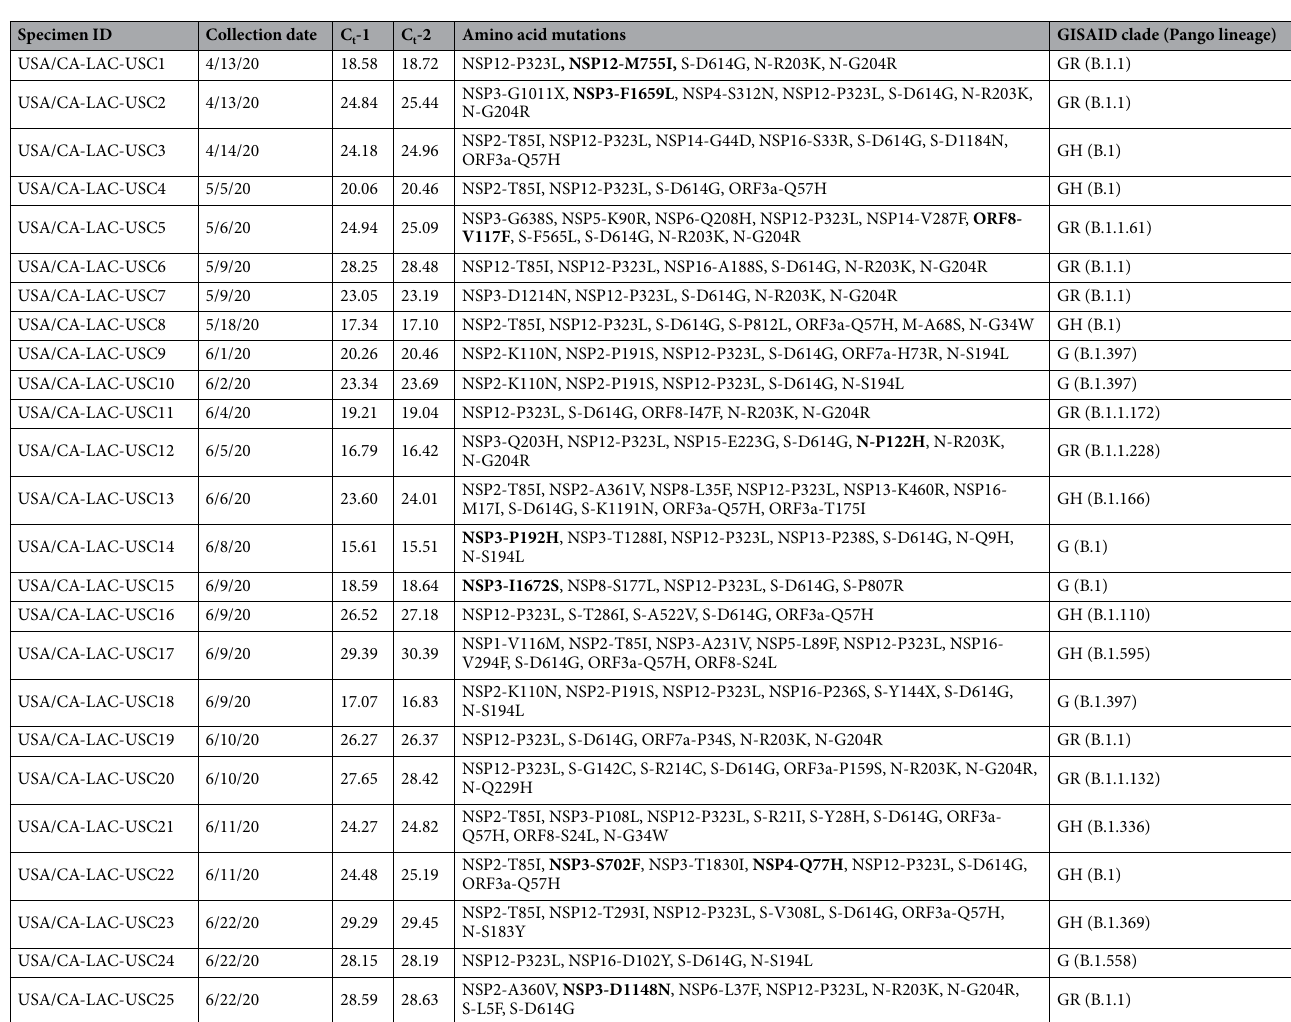
Table 1. Amino acid mutations, clade and lineage of 25 whole genome sequences from COVID-19 remnant NP/OP specimens. Novel amino acid mutations that were not observed among 28,176 global SARS-CoV-2 sequences in GISAID are in bold. C t -1 targeted the ORF1/a-b non-structural region and C t -2 a conserved region in the structural protein envelope E-gene. qRT-PCR was performed using the Roche COBAS